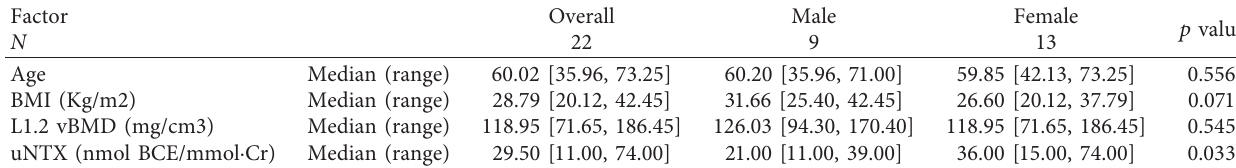
Table 2: Patient demographics.